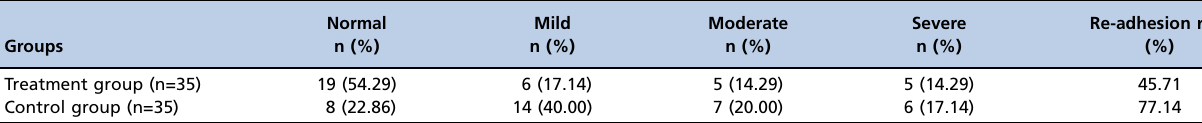
Table 2 - Hysteroscopic evaluation of the intrauterine cavity.